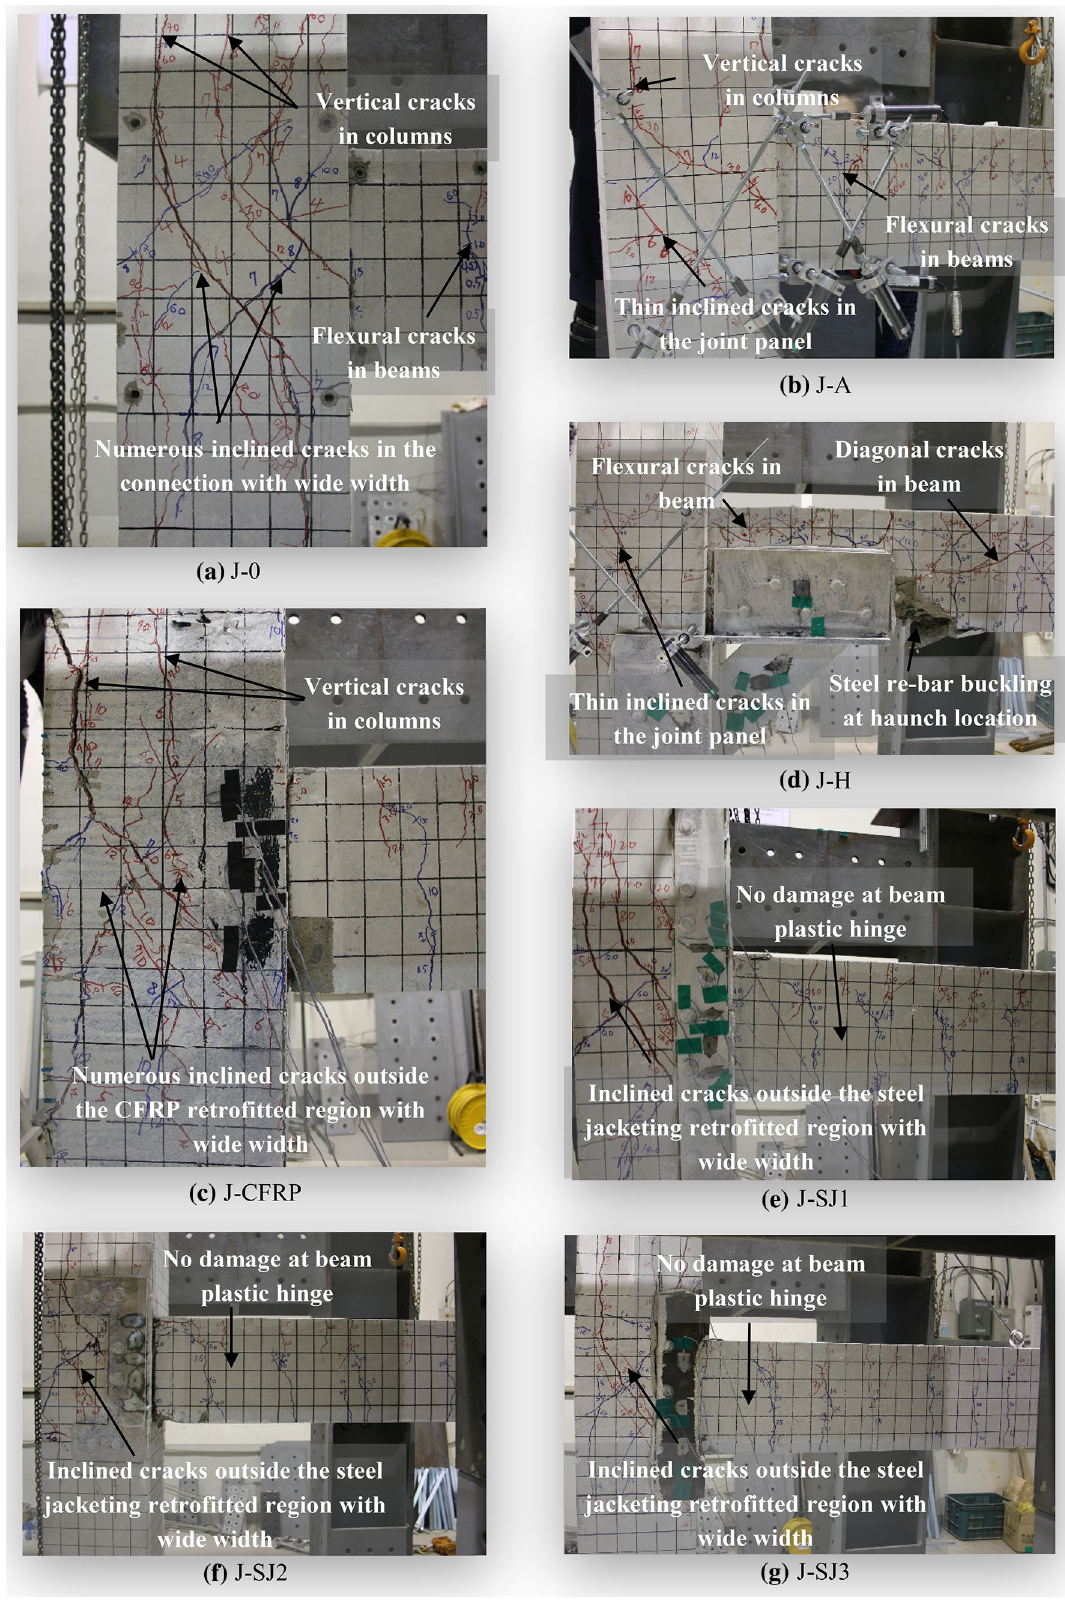
Fig. 14 Specimen damage at the end of testing: a J-0, b J-A, c J-CFRP, d J-H, e J-SJ1, f J-SJ2, and g